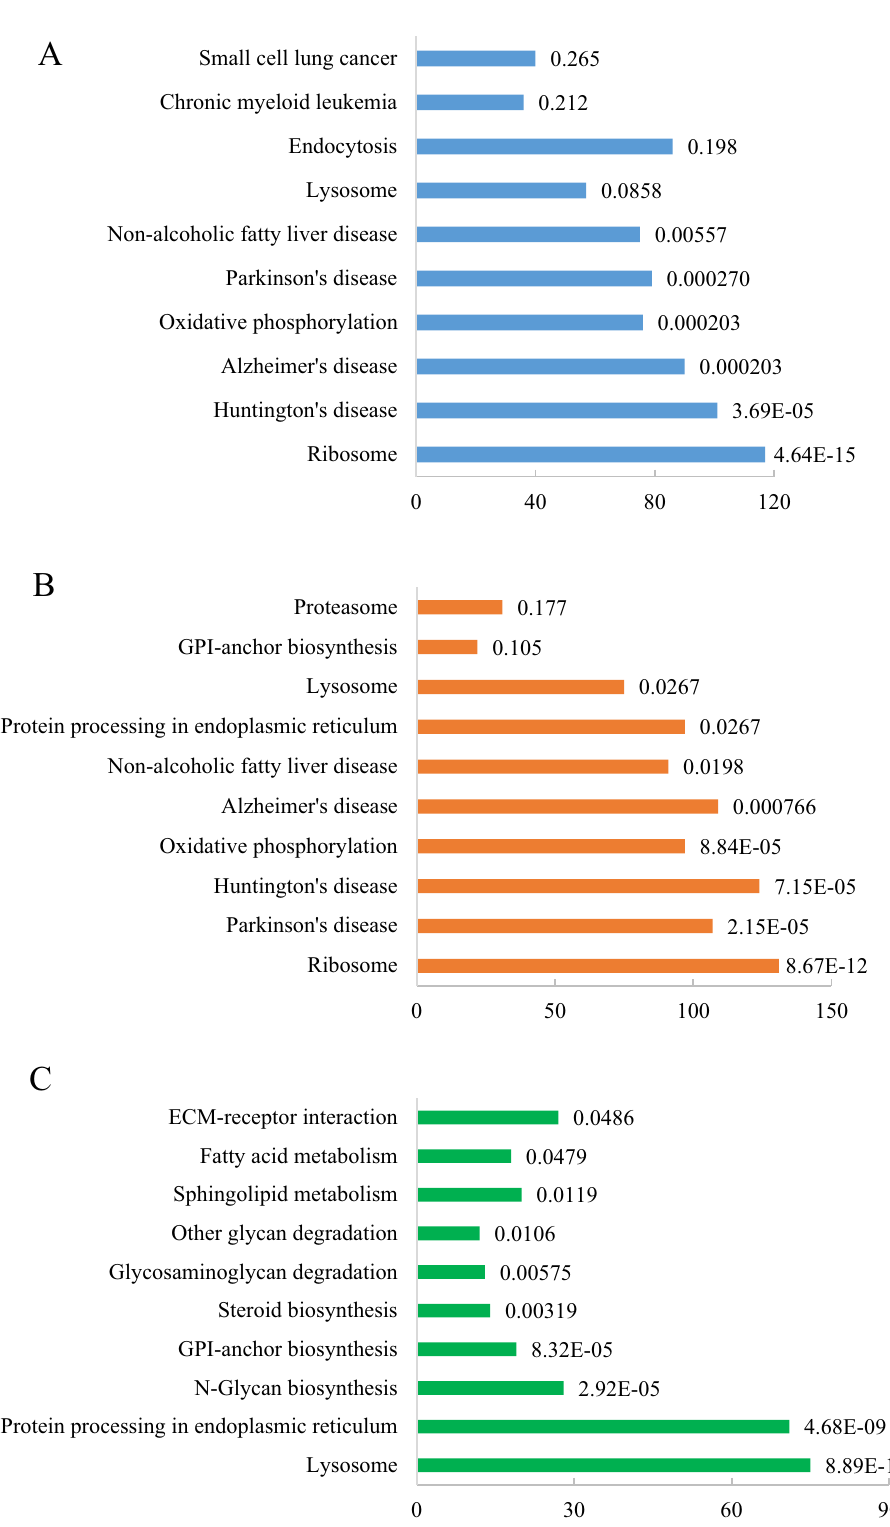
Fig. 6 The top 10 pathways enriched in KEGG-based analysis of DEGs in ( A ) UVB/Control, ( B ) UVB-JTE/Control, and ( C ) UVB-JTE/UVB, respectively. The adjusted P -values are annotated at the right of the bar